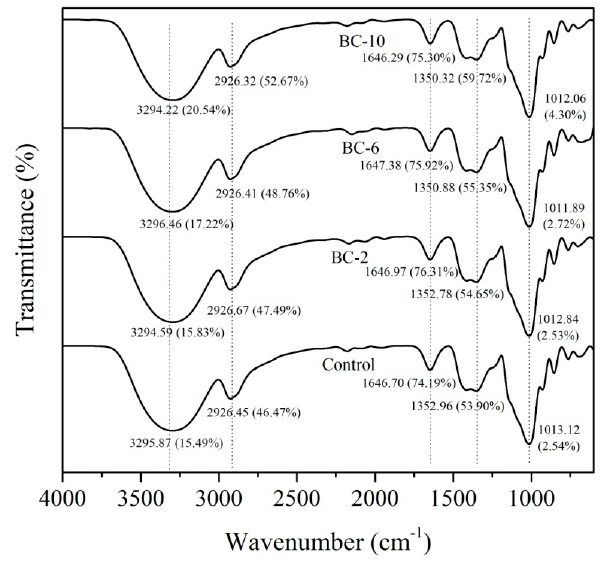
Figure 4. FTIR spectra of control and biocomposite films.